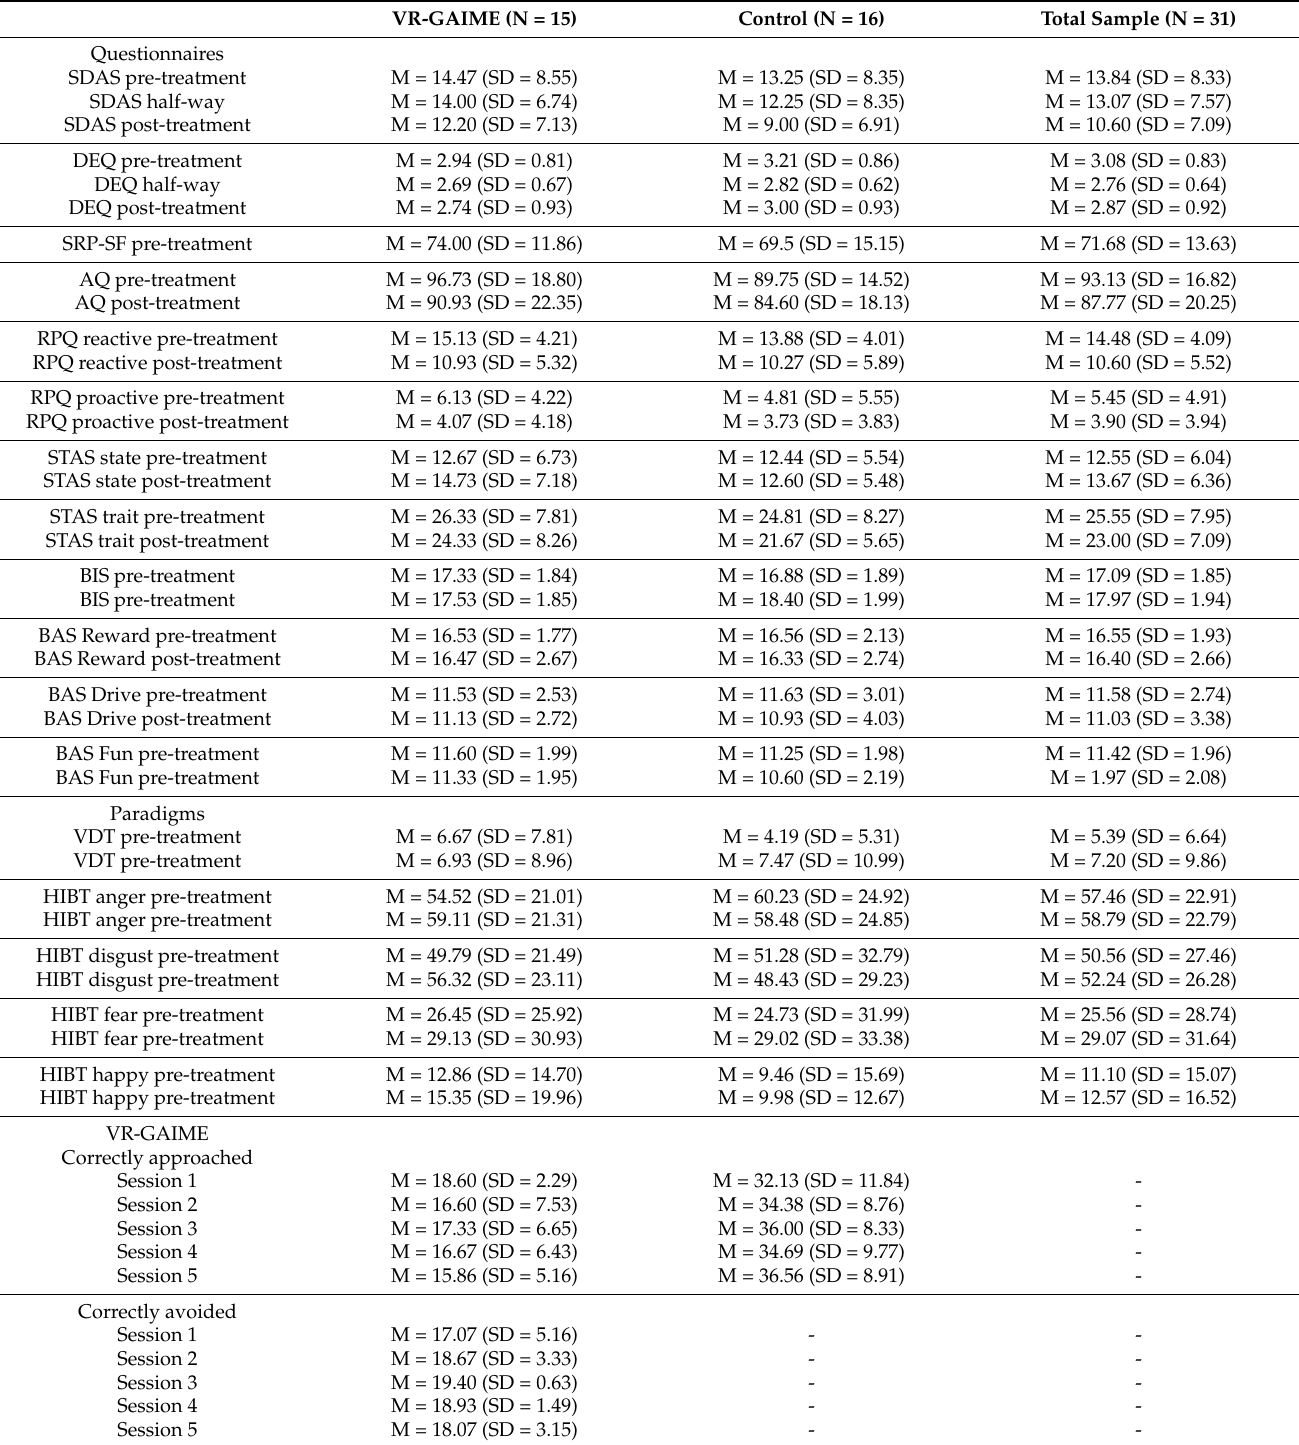
Table 3. Descriptives (Mean, SD) of the two treatment conditions and the total